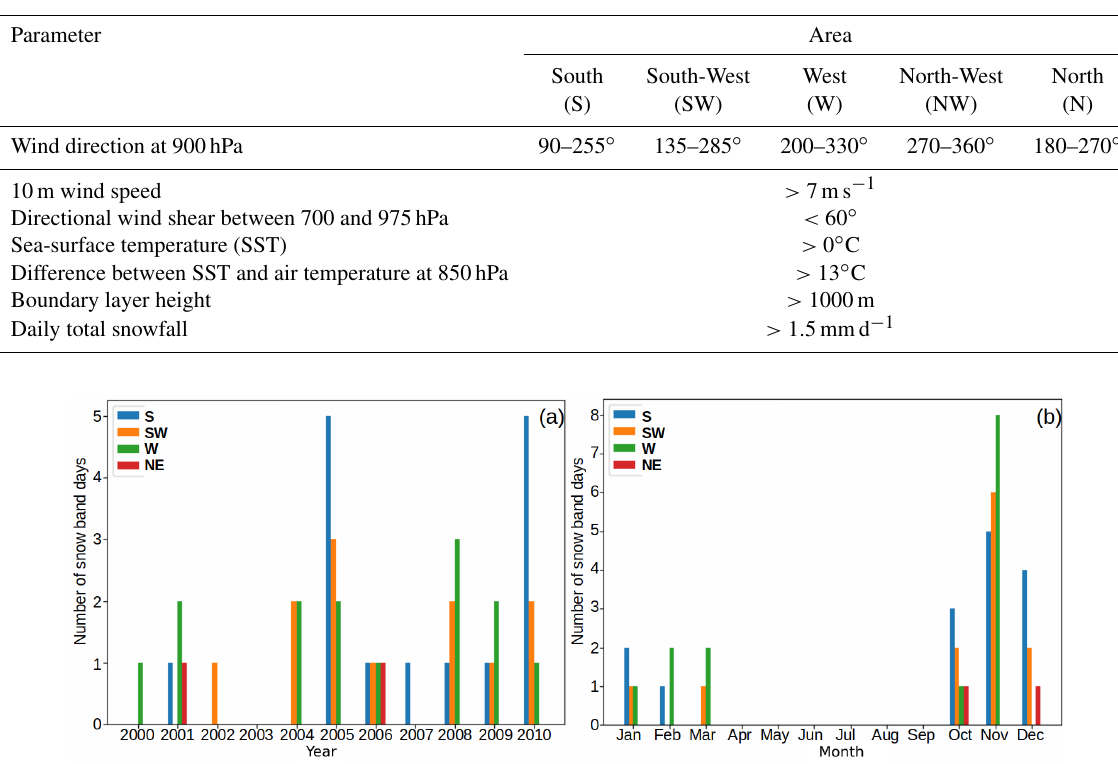
Figure 3. Total number of favorable days over the Baltic Sea during 2000–2010 per year (a) and month (b) in the different areas (shown in Fig. 2 and Table 1) based on RCA4 data. Area N is not included as no events were